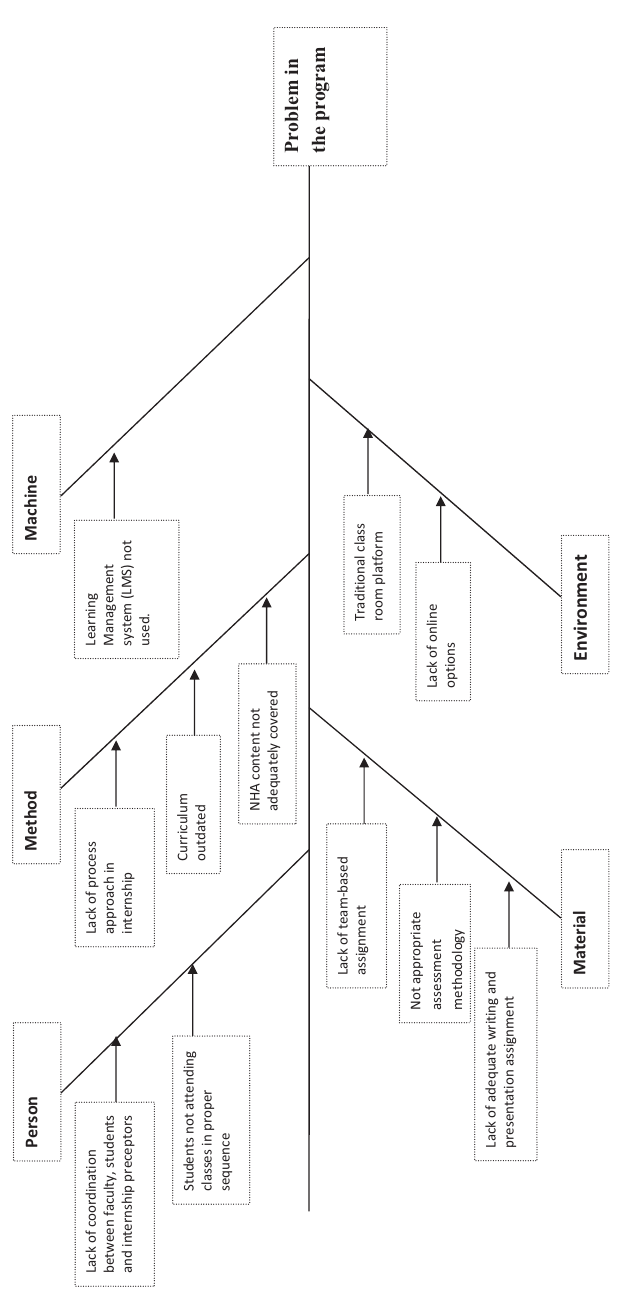
Figure 2. Fishbone